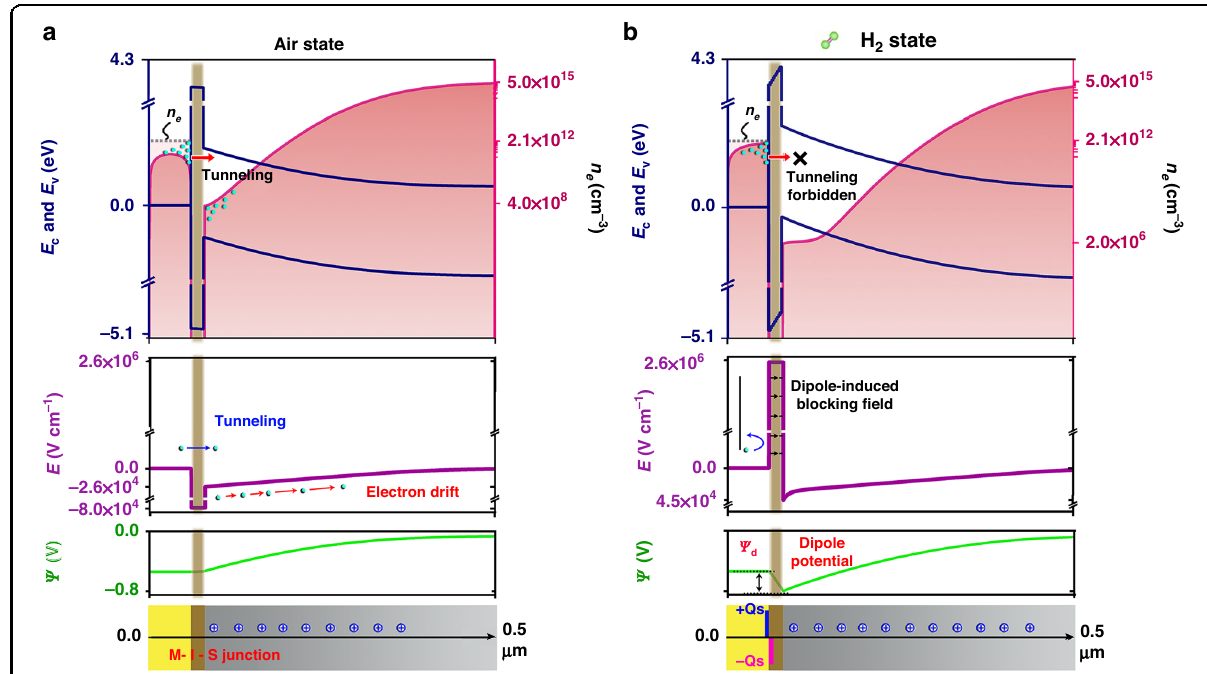
Fig. 3 TCAD model predicted electrical characteristics of the MIS junction under different gas atmospheres. a In air state. b In hydrogen- containing gas state. The panels from top to bottom represents: energy band diagram along with the electron pro fi les across the MIS junctions ( fi rst row), distributions of electric fi eld (second row) and potential (third row), and schematic of the space and dipole charge distribution near the MIS